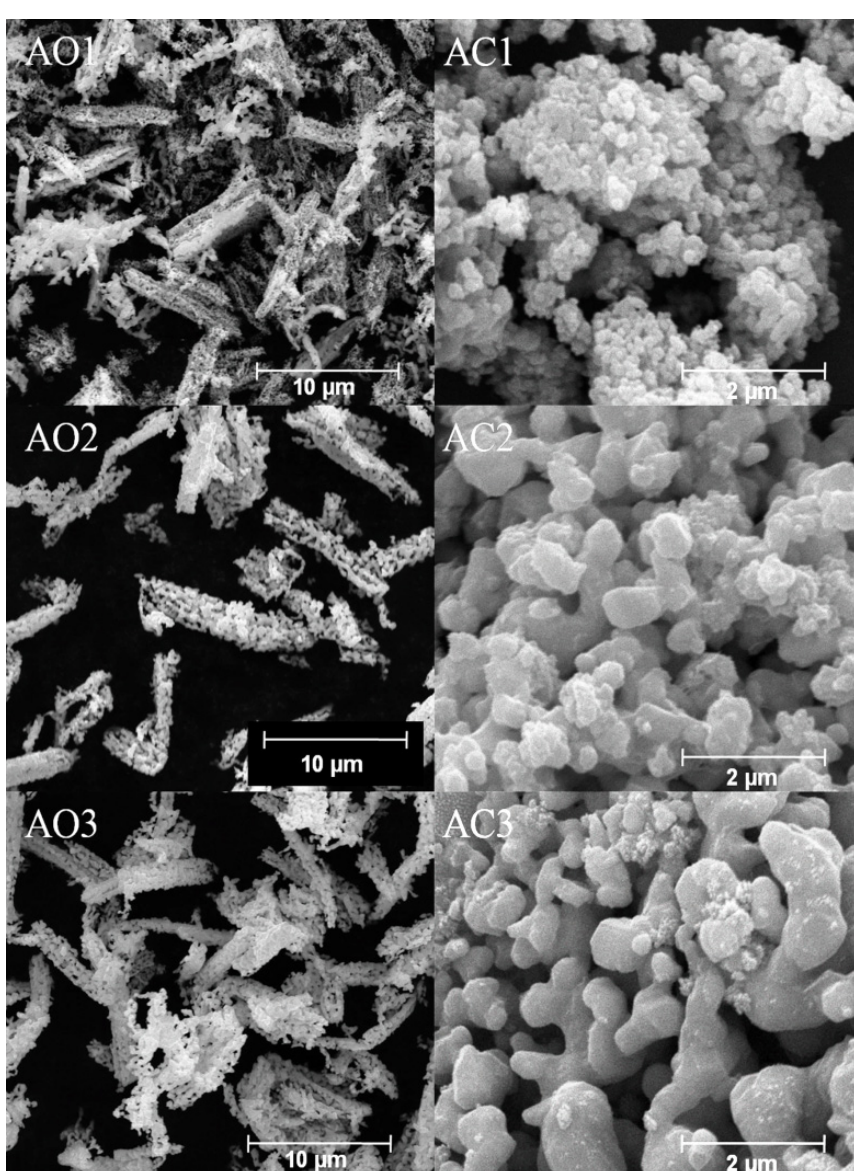
Figure 8. Morphologies of Co-Cr-V alloy powders.